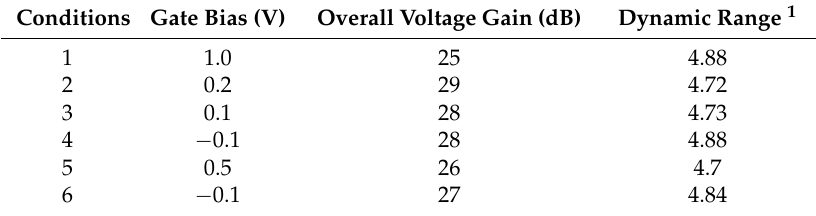
Table 1. Operating conditions of detectors in the signal conditioning block after the calibration process.